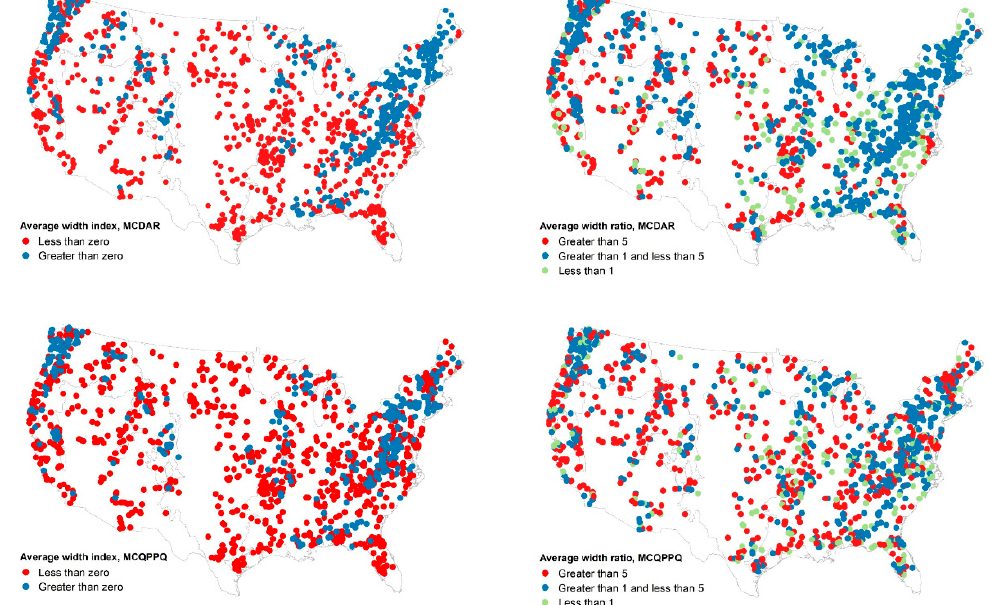
Figure 6. Average width index (AWI) and average width ratio (AWR) for 95 percent uncertainty intervals at 1331 validation sites using MCDAR and MCQPPQ simulation methods.